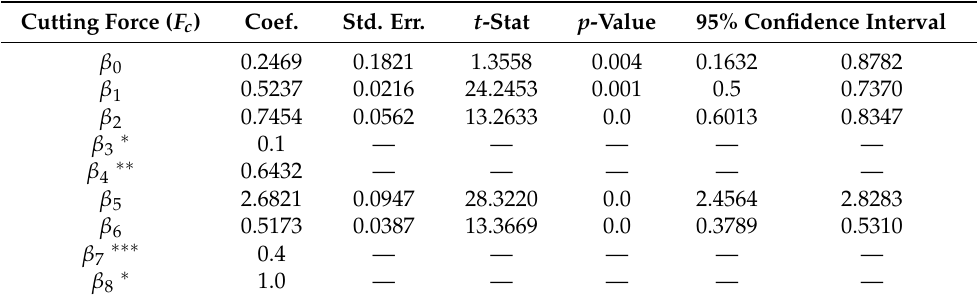
Table 8. Regression coefficients of cutting force along with t -test and p values. Cutting Force ( F c ) Coef.